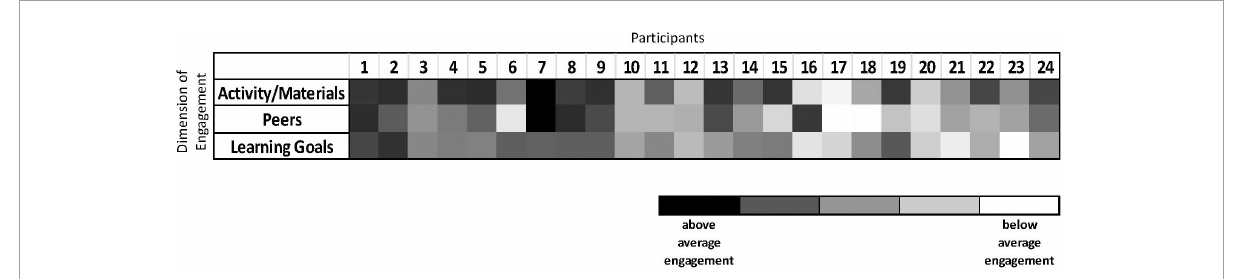
FIGURE6 Heat map of individual children’s multi-dimensional active engagement with the Block Play Intervention. Figure shows individual children’s engagement with activity/materials, peers, and learning goals across the Block Play Intervention. Each column represents an individual child, and the rows illustrate that child’s engagement with a specific dimension, relative to other children in the sample. Darker shades demonstrate that a child was increasingly above average, compared to the rest of the sample, on a dimension of engagement. Lighter shades demonstrate that a child was increasingly below average on a dimension of